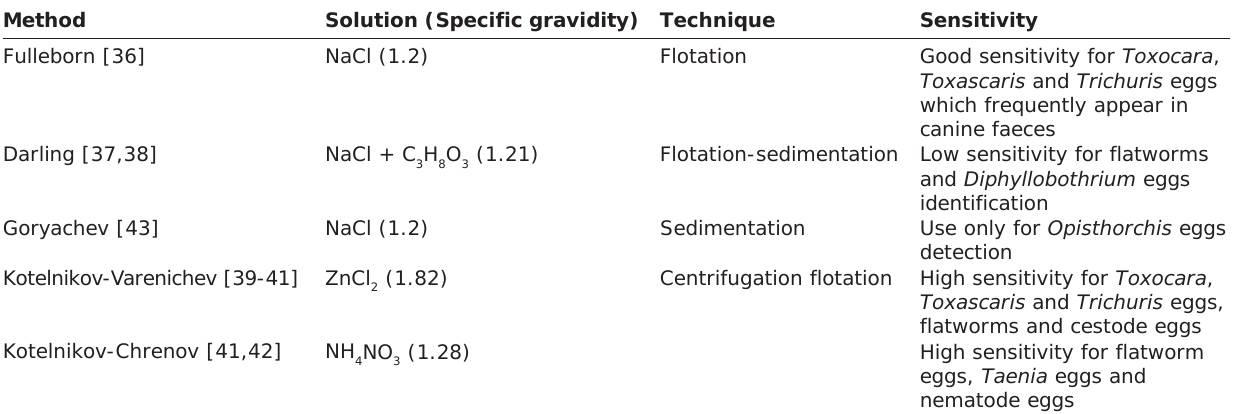
Table-4: Comparison of coproscopically examination method using in